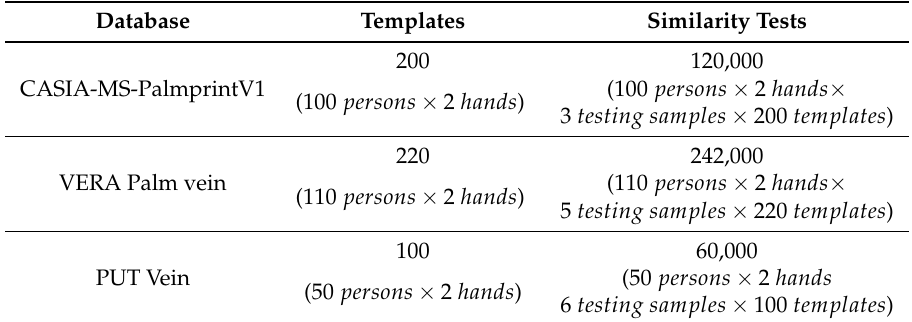
Table 5. Number of templates and similarity tests for the experiments in identification mode on each database.